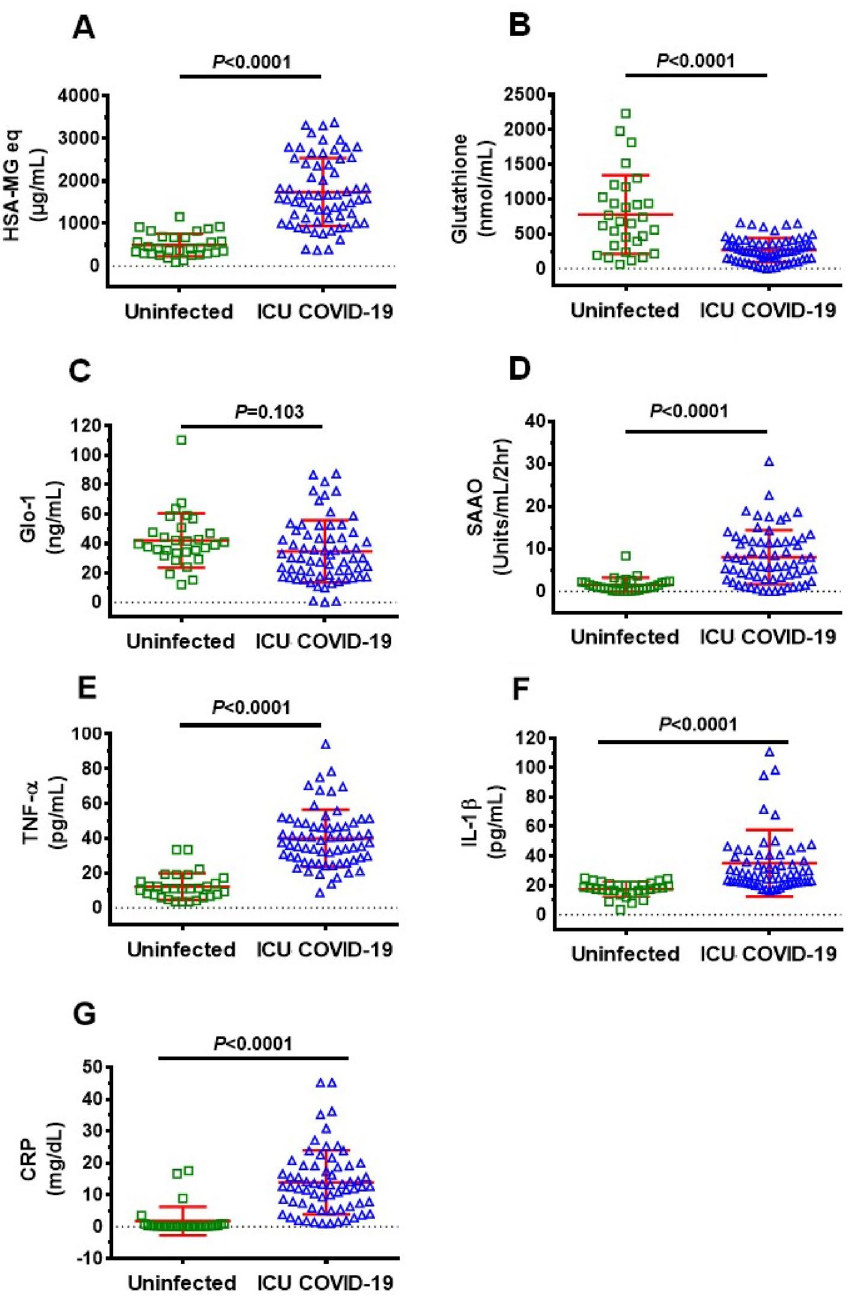
Figure 1. Plasma levels of MG, glutathione, Glo1 SSAO, TNF-α, IL-1β and CRP in uninfected control and ICU COVID-19 patients. ( A ) MG levels (detected as its surrogate, HSA-MG) were significantly higher in ICU COVID-19 patients compared to uninfected controls. ( B ) Glutathione levels were significantly lower in ICU COVID-19 patients compared to uninfected controls. ( C ) Glo1 levels in ICU COVID-19 patients were not significantly different from uninfected controls. ( D – G ) SSAO, TNF-α, IL-1β and CRP levels were significantly higher in ICU COVID-19 patients compared to uninfected controls, respectively. Data shown are for each patient with mean ± S.E.M from n = 30 uninfected controls (26.6% females) and n = 65 ICU COVID-19 patients (29.3% females). Statistical significances are shown above sets of data points on the